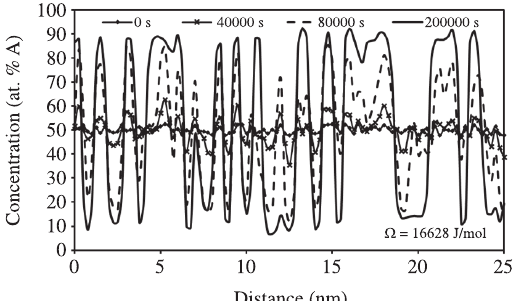
Figure 6. Concentration profile of the A-50at. % B alloy aged at 650 K for different times for Ω equation.